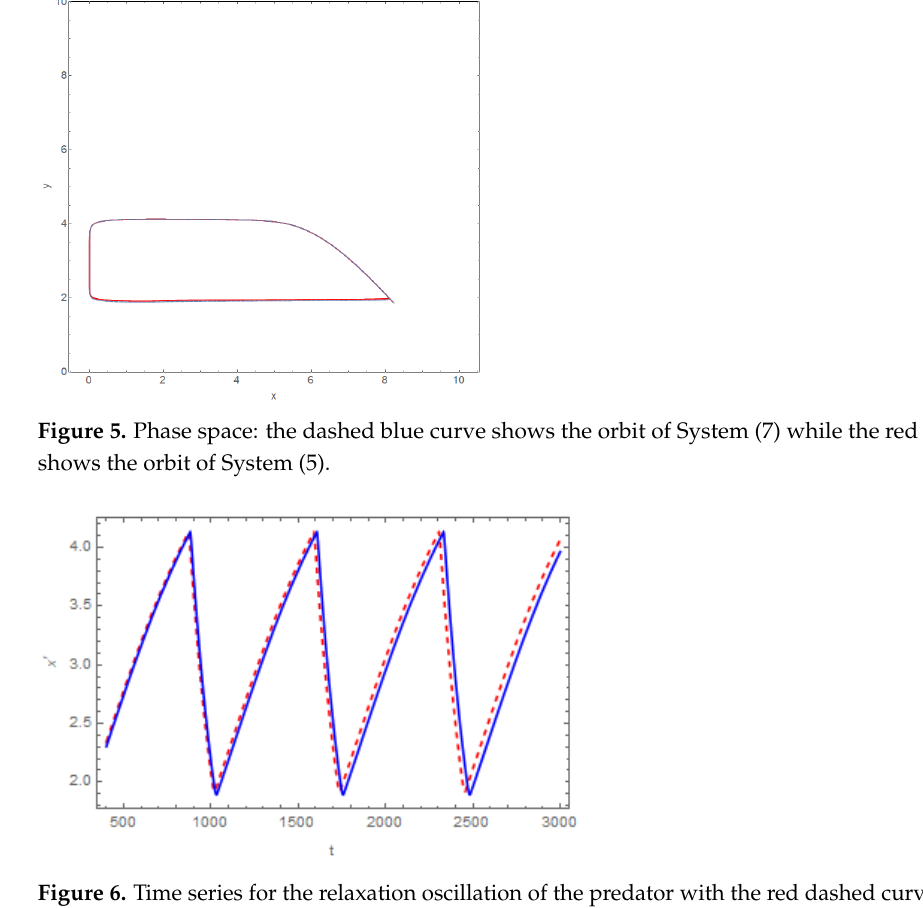
Figure 6. Time series for the relaxation oscillation of the predator with the red dashed curve (System (5)) and the blue full curve (System (7)).